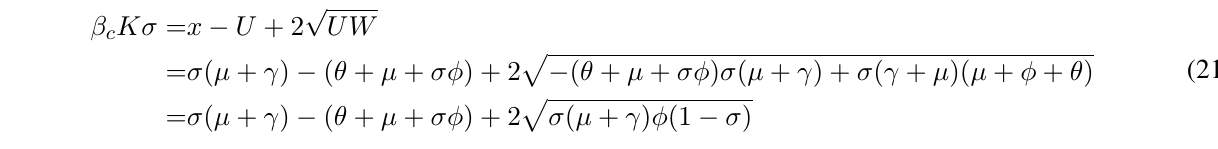
Fig. 3: Bifurcation diagrams for 20 different values of (a) ω and (b) η in the case when ( θ + µ + σφ ) 2 ≥ σ ( µ + γ )(1 − σ ) φ . The curves move to the left as the immigration parameter increases. We let Λ( x ) = x choose parameter values as (a) µ = 1 , γ = 7 . 5 , θ = 0 . 5 , σ = 0 . 02 , φ = 16 , c = 0 . 1 , d = 0 . 03 , (b) µ = 1 . 5 , γ = 11 , θ = 0 . 5 , σ = 0 . 02 , φ = 16 , c = 1 / 15 , d = 9 / 300